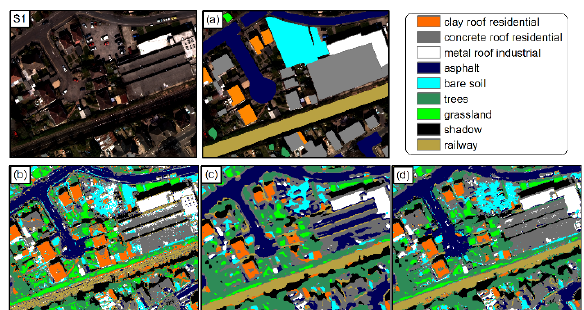
Figure 4. The partial region of the original image (S1), with (a) ground truths for validation, (b) the classification results of MLP, (c) the classification results of CNN, and (d) the classification results of MLP-CNN fused by the rough set decision